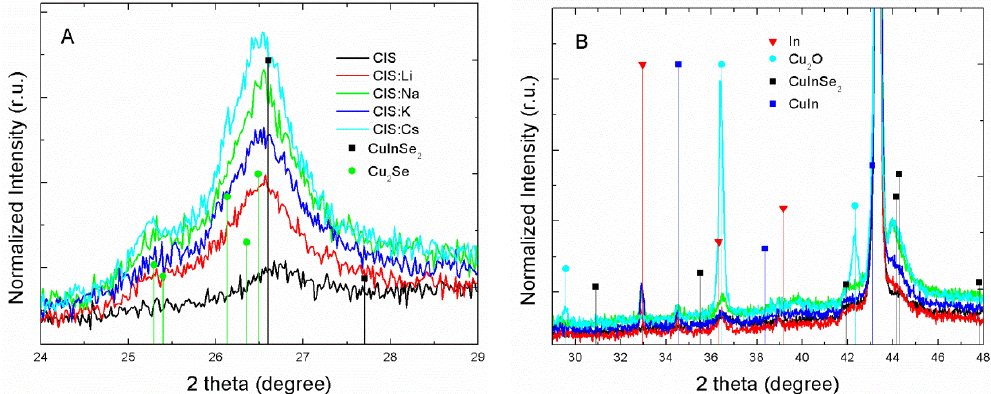
Figure 2. X-ray diffractograms of the prepared films. ( A ) Angular region around the main CIS peak; ( B ) whole Figure 2. X ‐ ray diffractograms of the prepared films.